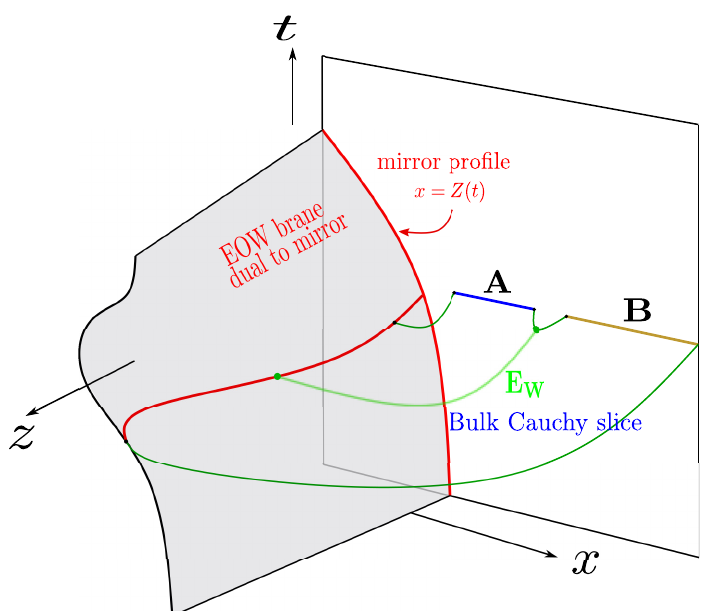
Figure 7. Schematics of the bulk entanglement wedge for the mixed state configuration of the two disjoint intervals in the dual moving mirror BCFT. The entanglement wedge is the region on the bulk Cauchy slice at coordinate time t which is enclosed by the subsystems A and B and the RT surfaces of A ∪ B . The EWCS for this configuration ends on the EOW brane which is holographically dual to the moving mirror boundary. Figure modified from [60].